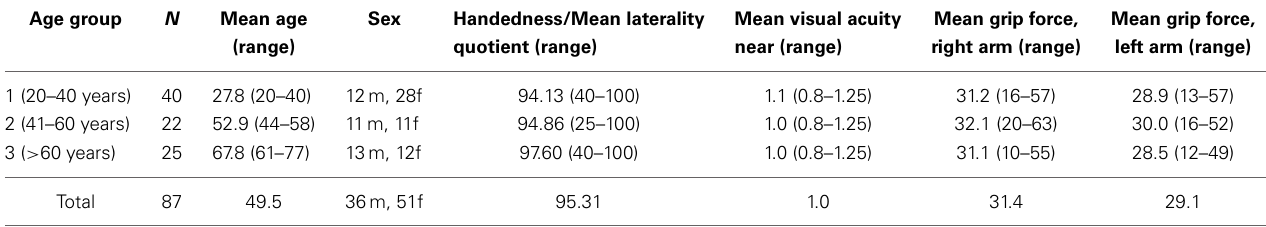
Table 1 | Demographical and experimental data of the three age groups and total